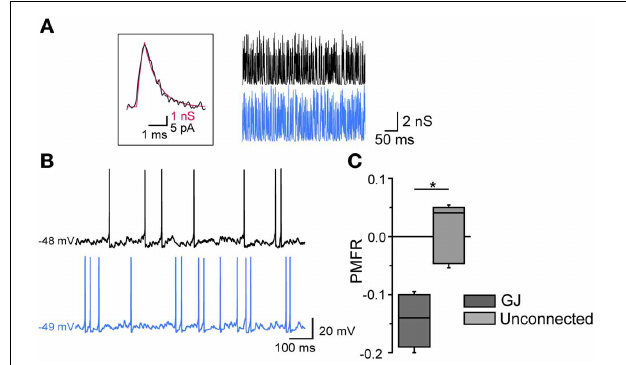
FIGURE 6 | Gap-junction-mediated firing inhibition in FSI pairs stimulated by arrays of sEPSCs in dynamic-clamp configuration. (A) Left, unitary sEPSC conductance (red trace) superimposed to a unitary spontaneous EPSC (black trace) recorded in FSIs in voltage-clamp mode ( V clamp = − 70mV; average of 30 EPSCs recorded in 6 different FSIs). The EPSC waveform was reversed and scaled to that of the sEPSC in order to show matching kinetics (10–90% rise time: 0.3ms; τ dec : 0.85ms). Right, Poisson trains of sEPSCs (300Hz, 500ms; segments excerpted from traces lasting 15–20s) used as dynamic-clamp waveforms. (B) Action potential firing in two GJ-connected FSIs stimulated by sEPSC trains shown in (A) in the presence of 10 μ M gabazine. (C) Summary of PMFR values for GJ-connected and unconnected FSI pairs ( n = 6, ∗ p < 0 . 05, Mann-Whitney U